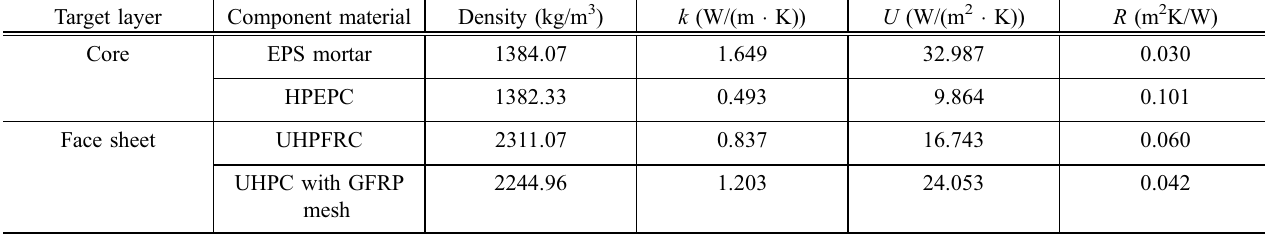
Table 6 Thermal properties of component